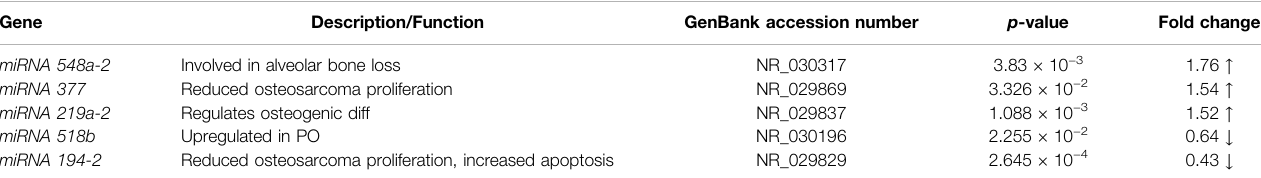
TABLE 5 | Selected differentially regulated microRNAs in hMSCs upon